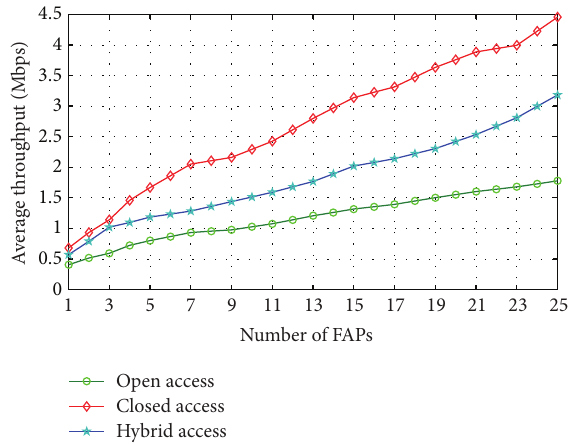
Figure 3: Average throughput of total users for variable numbers of FAPs.